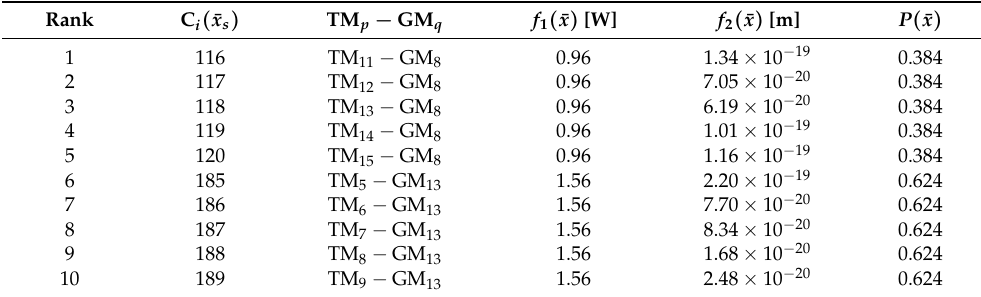
Table 3. Results of the individual objective functions and the Performance Function P ( ¯ x ) of the ten best